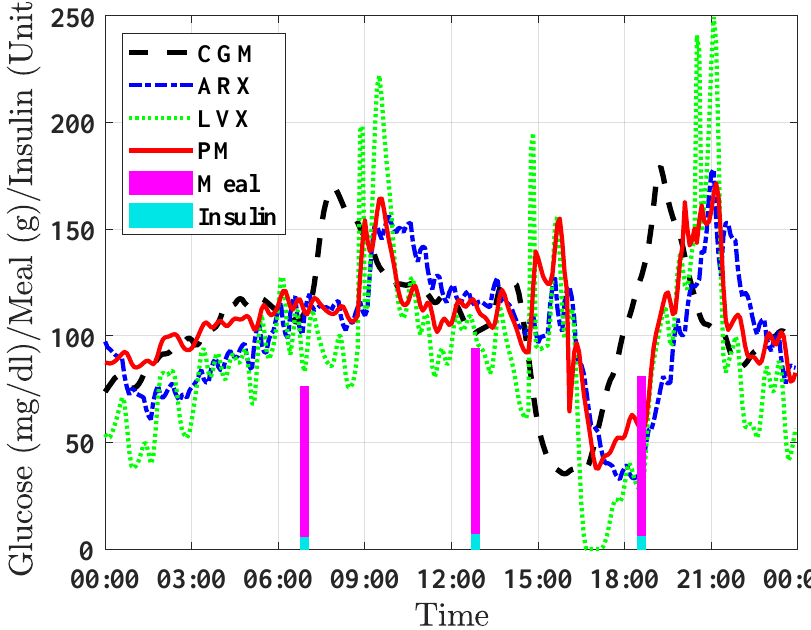
Figure 4. Example of 24 h period close up for a representative real individual showing the prediction results for the three evaluated forecasting methods with a prediction horizon of 120 min. The continuous glucose measurements is represented by the dashed black line, the prediction by the proposed PM method is displayed in solid-red line, results for the LVX and ARX methods are showed in dotted green line and dash-dotted blue line respectively. Vertical pink bars indicate carbohydrate intakes (grams) and vertical light blue bars indicate insulin boluses